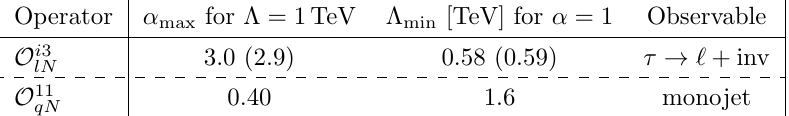
Table 6 . Maximum (minimum) value of (cid:11) ((cid:3)) for (cid:3) = 1 TeV ( (cid:11) = 1) allowed by the observables quoted in the last column for LLRR operators. The numbers outside (inside) the parentheses refer to ‘ = e ( (cid:22)